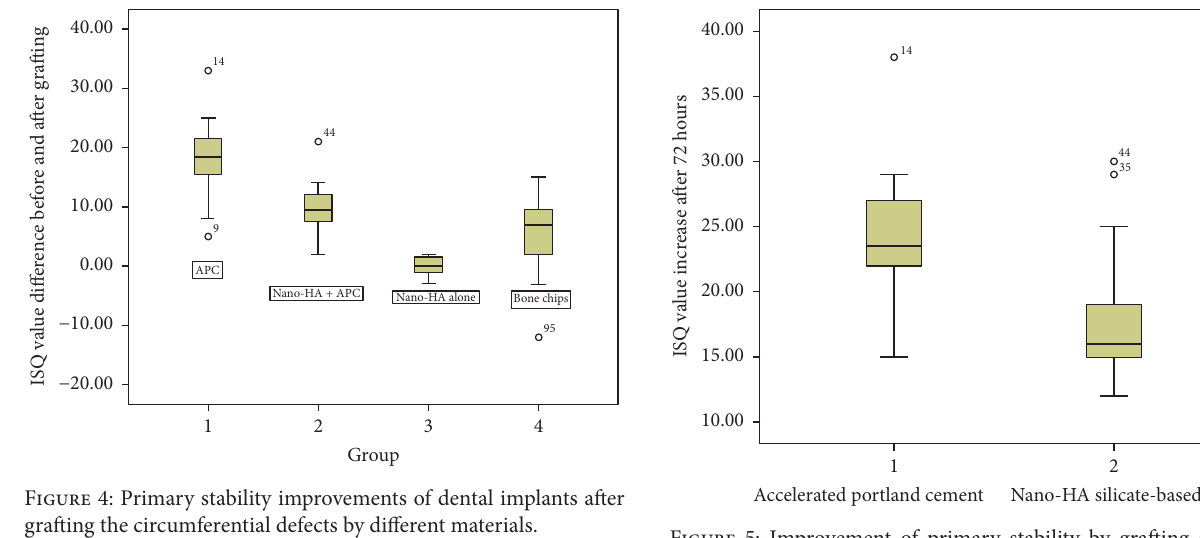
Figure 5: Improvement of primary stability by grafting of bone defect after 72